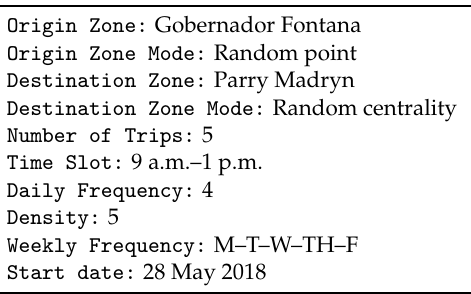
Table 2. Parameter setup.